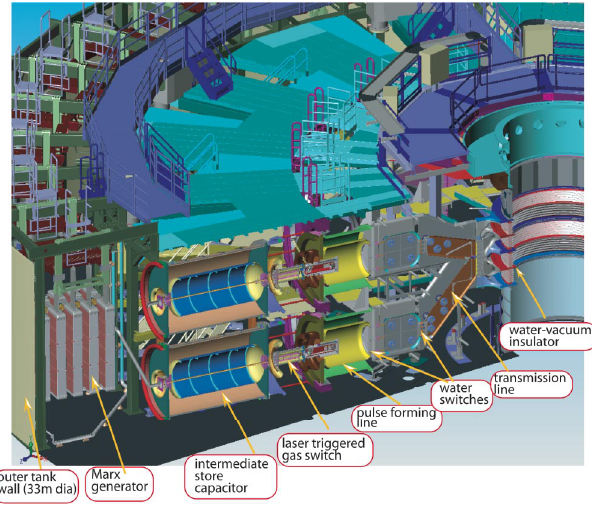
FIG. 1. (Color) Cross section of the refurbished Z driver. The outer tank wall is 33 m in